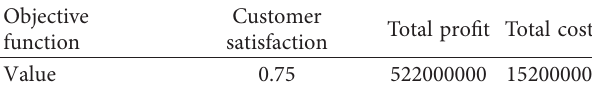
Figure 4: The process of NSGA-II evolution. Table 2: Value of objective function.